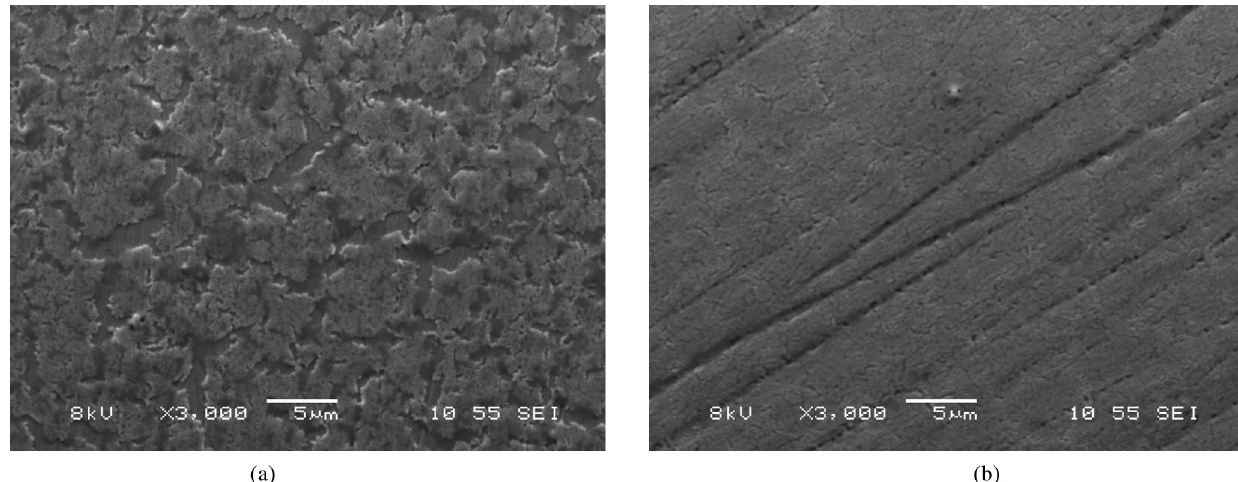
FIG. 20. SEM images at 3000x magnification using an 8 keVelectron beam at photocathode locations that had been illuminated with 2 W laser light, in one case (a) while extracting beam at 10 mA using a laser spot 1050 (cid:1) m FWHM and the other case, (b) simply heating the photocathode with a laser spot 500 (cid:1) m FWHM without generating beam. The topology of these two locations was very different, and very different from that of photocathode #1.